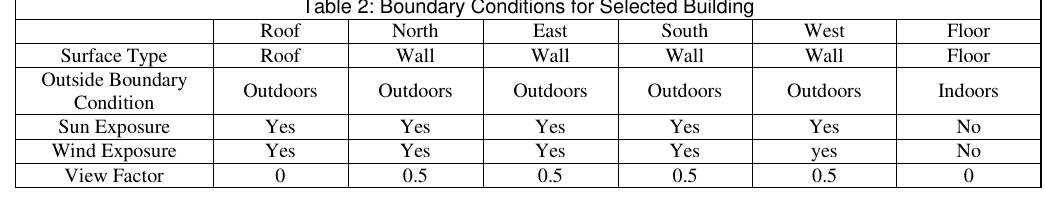
Table 3: Physical Properties of Cool Roof Materials